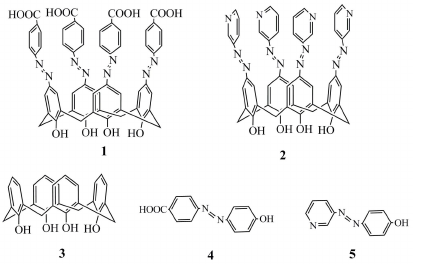
Figure 1. Chemical structures of azocalix[4]arene derivatives 1 and 2 , calix[4]arene ( 3 ),